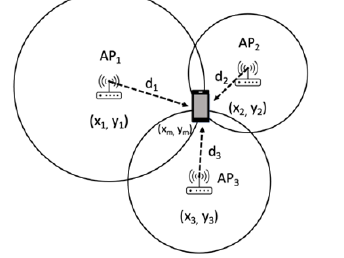
Figure 2: Finding a location via UWB using the TOA and Trilateration technique